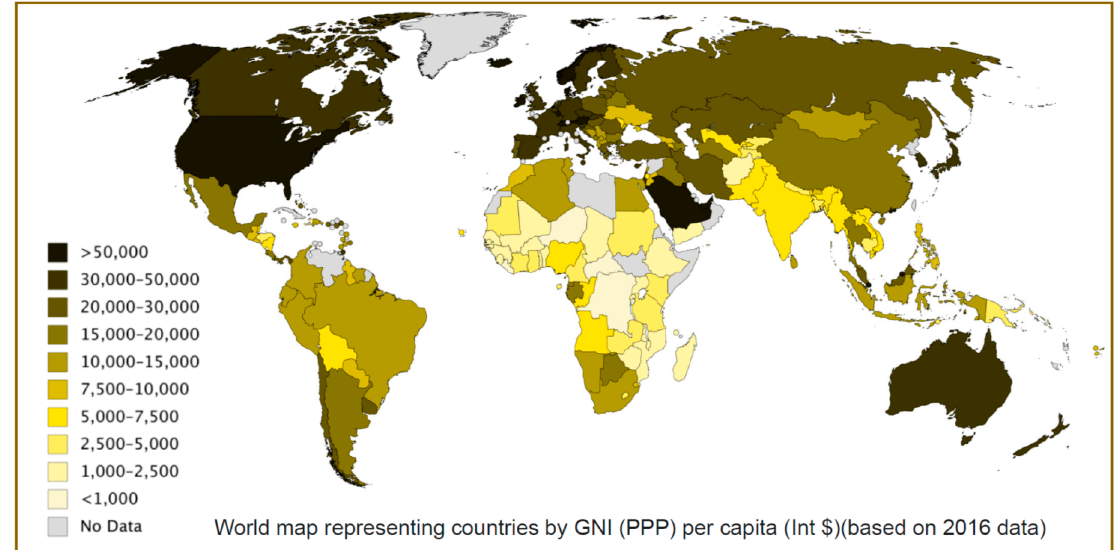
Figure 6. Geographical distribution of a decent standard of living index: gross national income (GNI) per capita at purchasing power parity (PPP) (in international dollars).